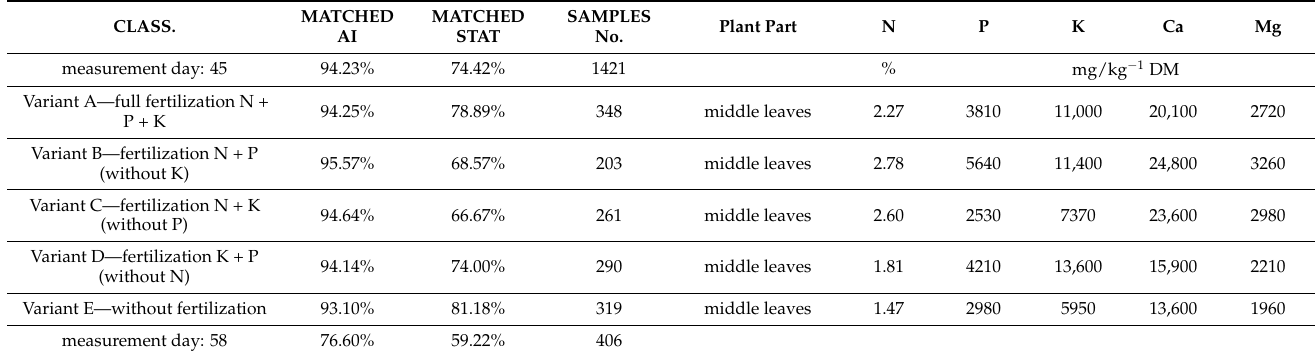
Table 2. Fertilizer group recognition broken down by measurement day and analytical method. ‘MATCHED AI’—AI approach, ‘MATCHED STAT’—a statistical